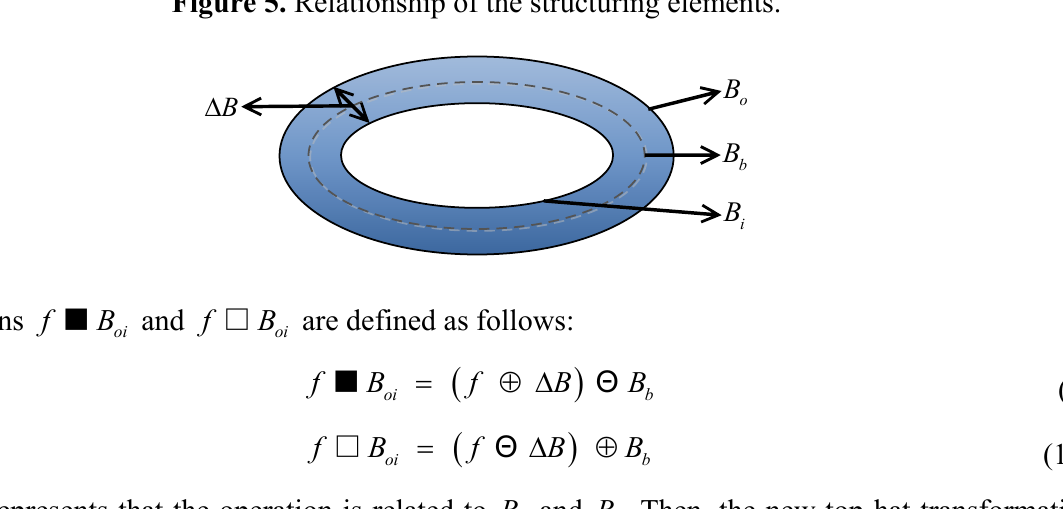
Figure 5. Relationship of the structuring